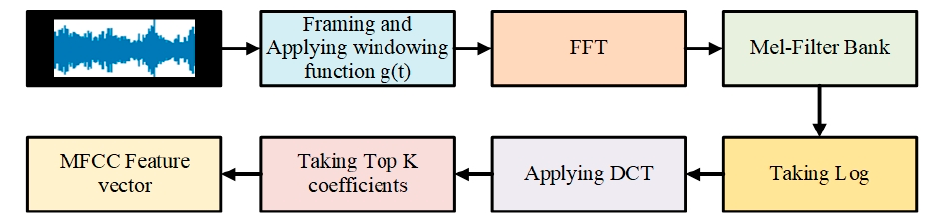
Figure 6. Evaluation of MFCC .